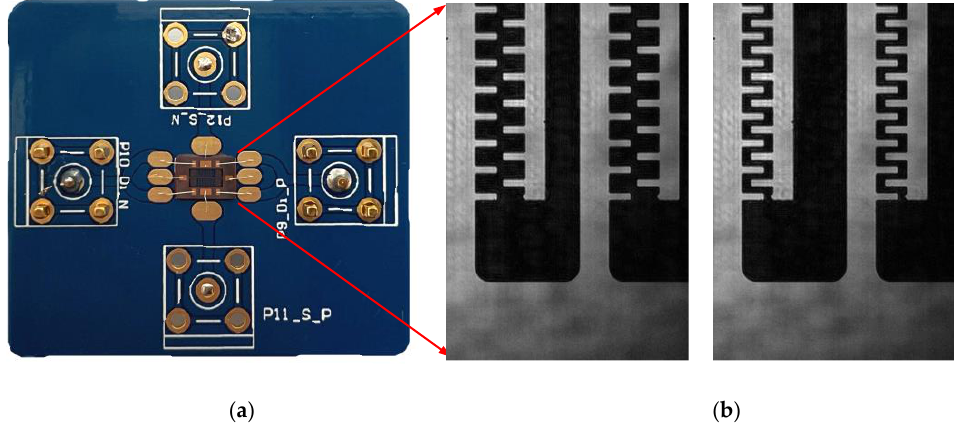
Figure 13. MEMS electrostatic comb resonator images: ( a ) PCB image; ( b ) SEM images of different movement displacement.